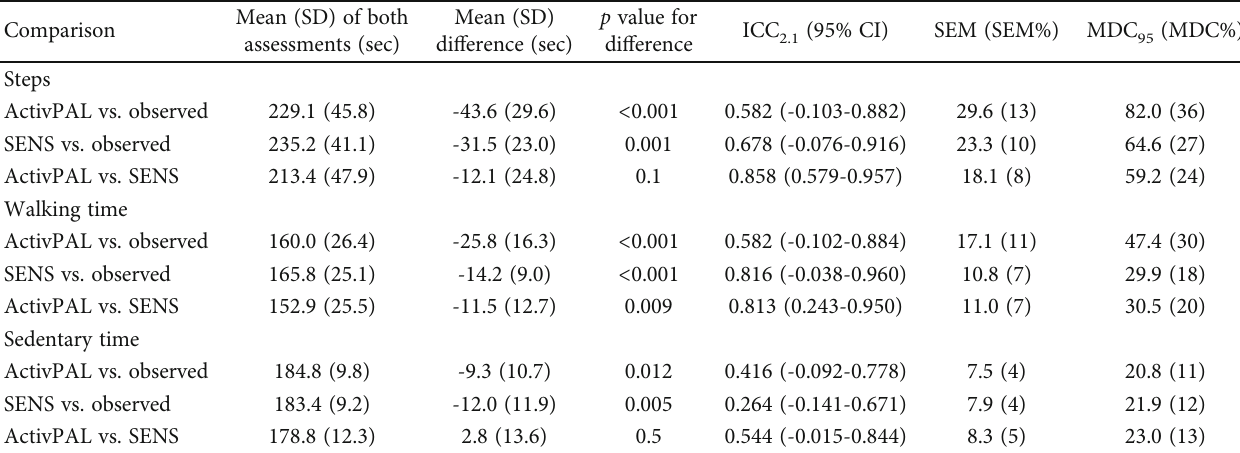
Table 7: Relative and absolute reliability of steps, walking, and sedentary time assessed with ActivPAL3 ™ , SENS motion®, and direct observations in older medical patients ( N = 12 ).